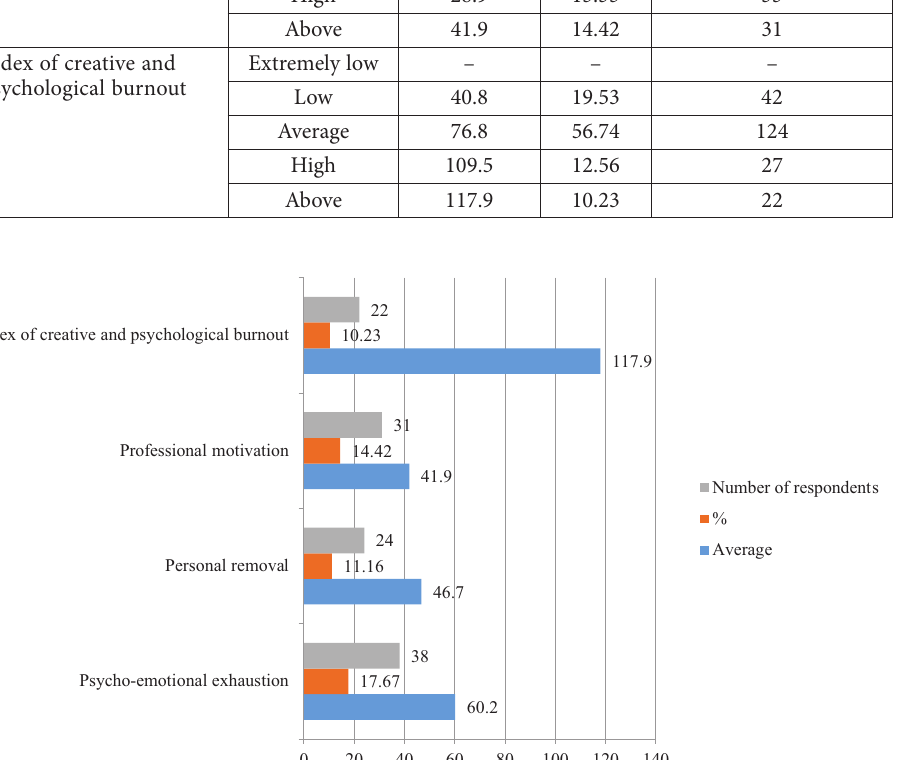
Figure 1. Super-high rates of creative and mental burnout (source: created by